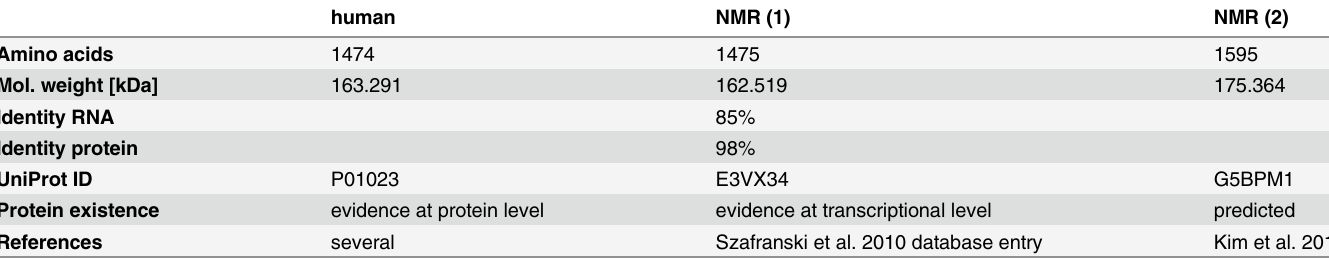
Table 1. Comparative analysis of the human and naked mole-rat (NMR) alpha 2-macroglobuolin sequence.